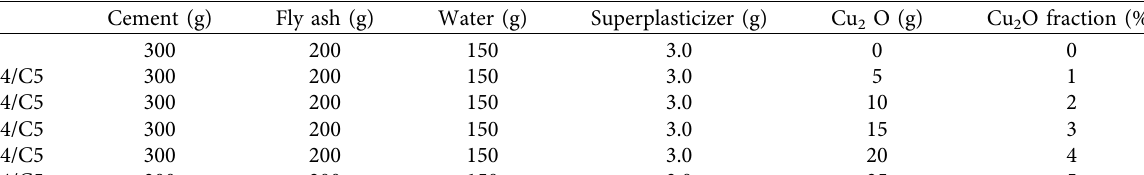
Table 2: Composition of the cement paste mixtures.